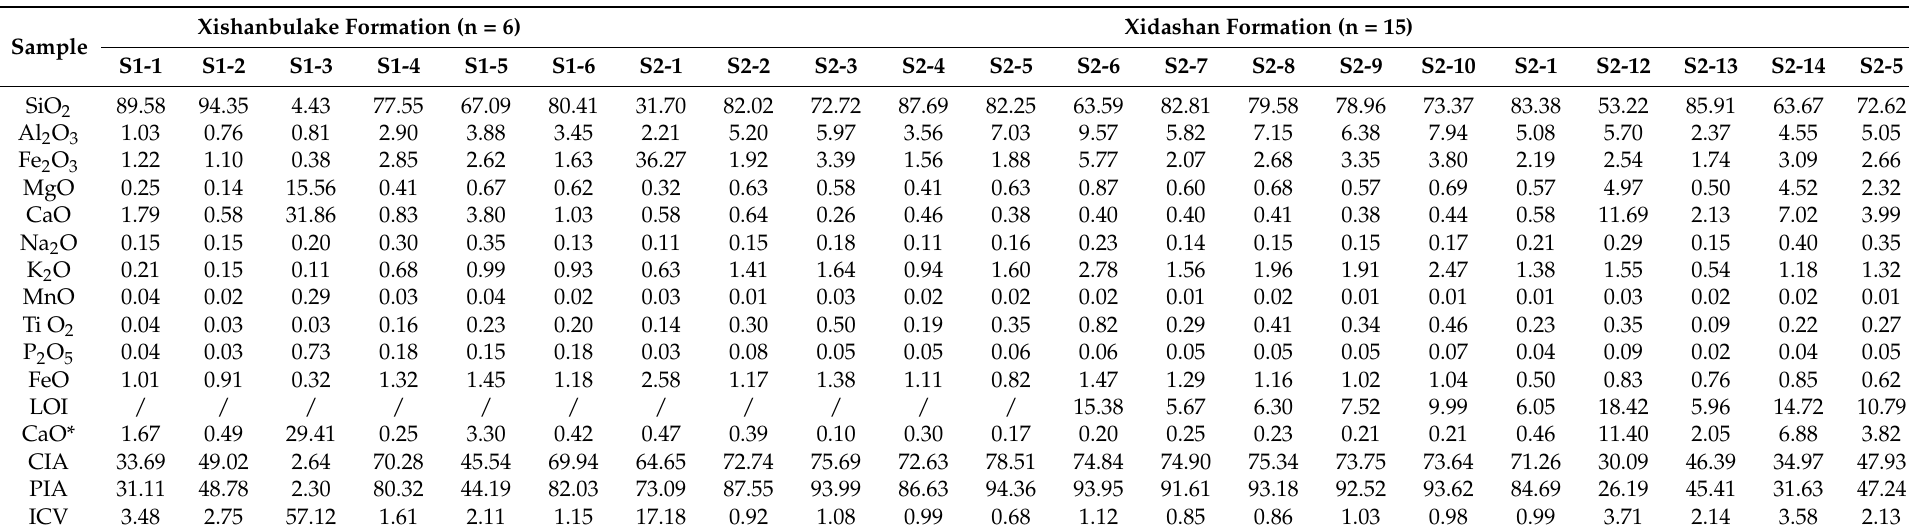
Table 1. Major element concentrations (in %) for Lower Camnrian mudstones in the study area.